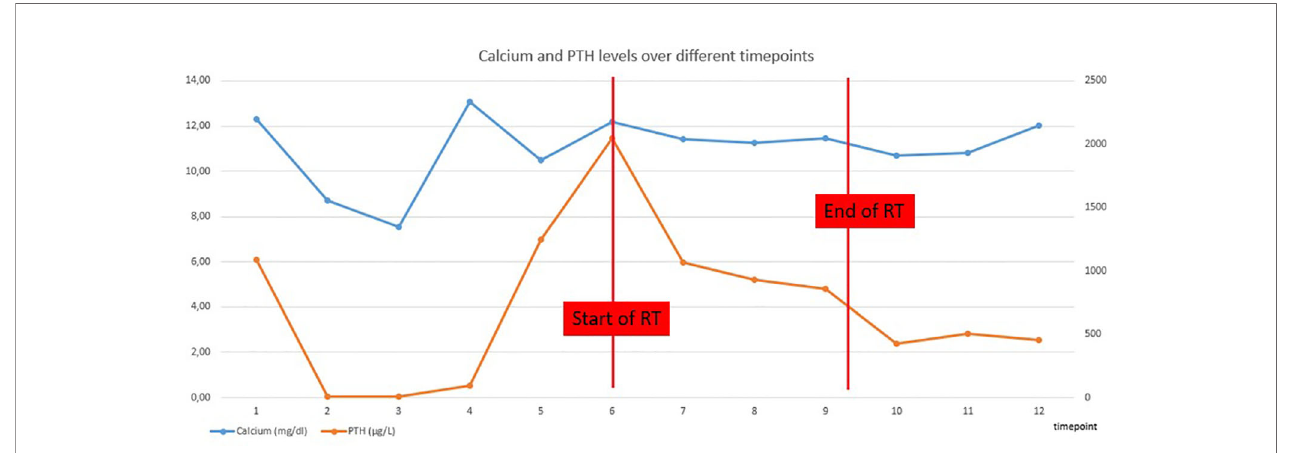
FIGURE 1 | Evolution of serum calcium and